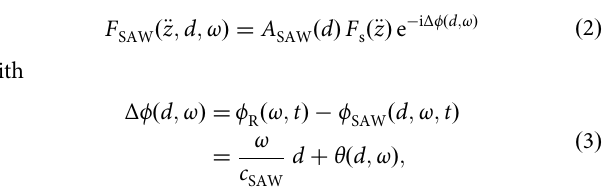
Fig. 1 Pillar resonators coupled by surface acoustic waves (SAWs). Schematic of the symmetric mode of two identical SAW-coupled pillar resonators for two different moments in time. The solid and dashed blue lines show the amplitude of the SAW emitted by each pillar along the y-direction. a At t 0 the pillars' displacement is maximal and ( b ) minimal half a period T later. The pillar resonators vibrate in the fi rst bulk/compression mode and emit SAWs, which exert an effective force F SAW on the other